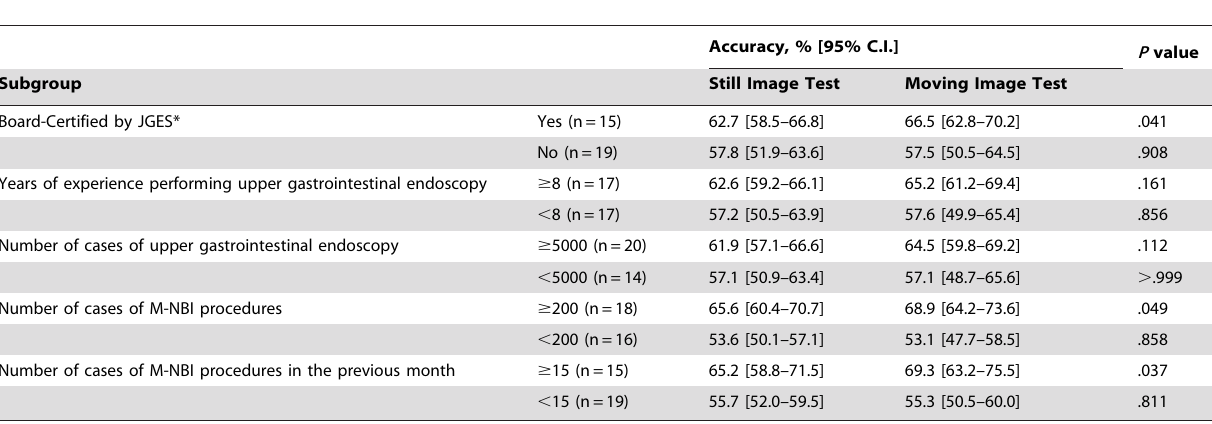
Table 7. Diagnostic Accuracy of Still Image Test versus Moving Image Test in the Subgroups of Endoscopist Characteristics.